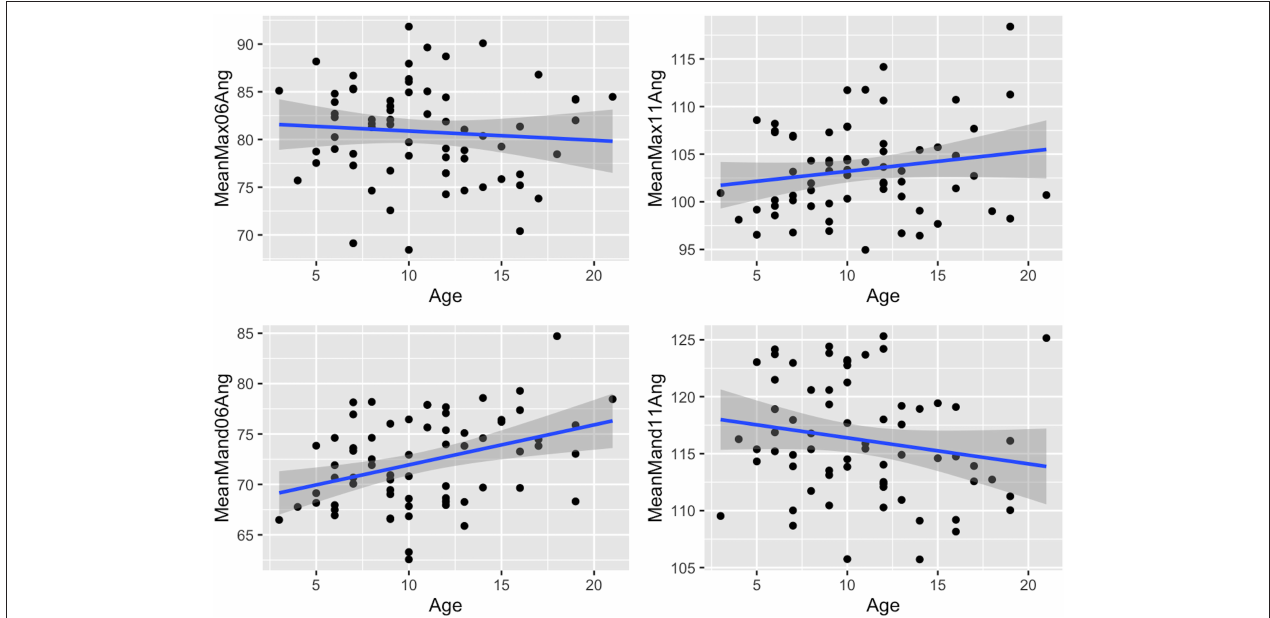
FIGURE 8 | Scatterplots with linear regression lines (blue) and confidence intervals (dark gray shading) plotted, showing associations between age (years) and crown angles (mean of left and right) of the Triadan 06 and 11 teeth in 67 horses. MeanMax06Ang, maxillary 06 angle; MeanMax11Ang, maxillary 11 angle;